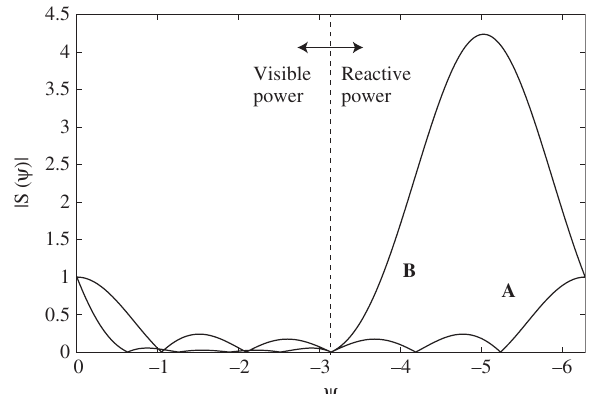
Figure 3: The space factors for (A) a uniform array of 6 elements and (B) an array of 6 elements with compressed zeros, as a function of argument of z .